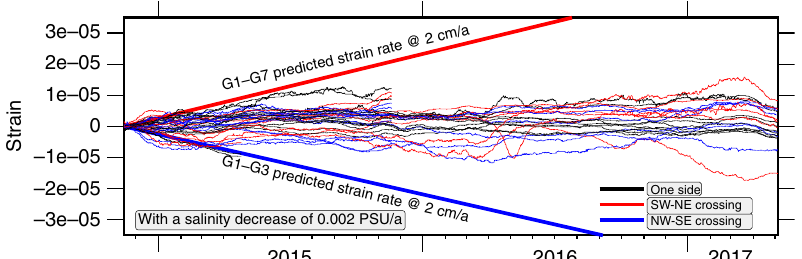
Fig. 4 Strain of all baselines. Strain (monthly medians) estimated from the measured travel times and calculated sound speeds based on pressure, temperature and a linear salinity decrease of 0.002 PSU yr − 1 . Baselines not crossing the fault (e.g. subparallel to the NAF) are shown in black; for a simple, east-west oriented, right-lateral strike-slip fault, baselines oriented southwest-northeast (red lines) should lengthen and those oriented northwest- southeast (blue lines) should shorten. Predicted strain rates correspond to a strike-slip movement reaching the sea fl oor